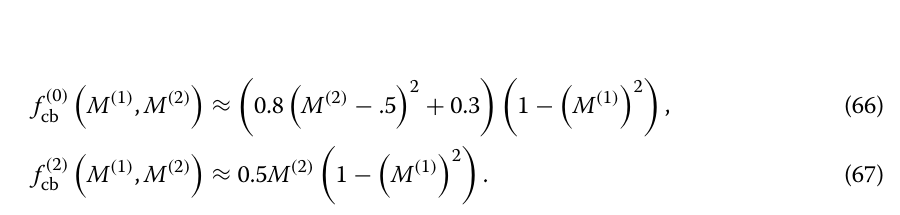
(cid:15) (cid:15) (cid:16)(cid:16) 0.5 1 − x 2 predicted